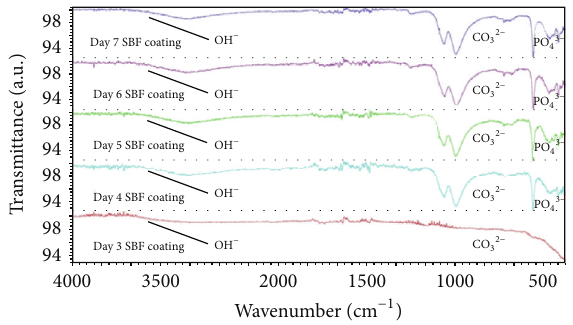
Figure 2: Showing the FTIR spectrum peaks for CPTi surfaces. Wavenumber (cm −1 ).